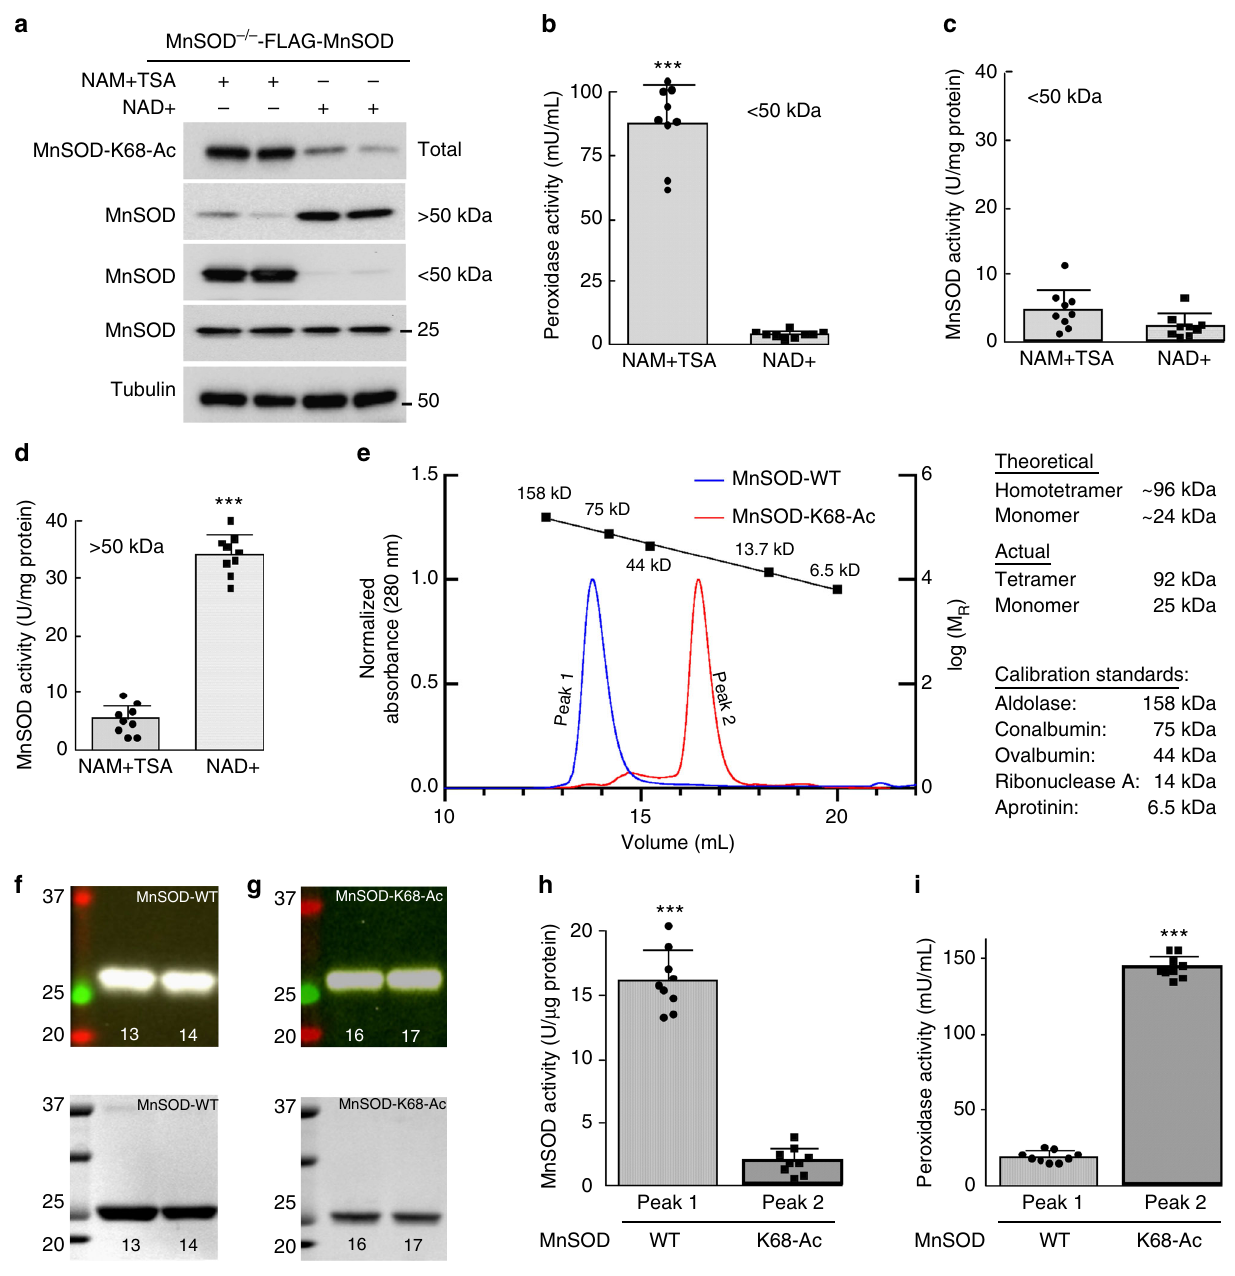
Fig. 4 The physical acetylation of MnSOD-K68 produces peroxidase activity. a – d Immortalized MnSOD − / − MEFs expressing Flag-MnSOD WT were cultured in NAM + TSA or NAD + , separated using a 50 kDa molecular cutoff membrane and a MnSOD-K68-Ac, MnSOD, and actin immunoreactive protein levels were determined. b Peroxidase activity and c MnSOD activity in < 50 kDa fractions. d The > 50 kDa fractions were analyzed for MnSOD activity. e Bacterially produced and puri fi ed recombinant MnSOD-WT and MnSOD-K68-Ac proteins were characterized by size exclusion column chromatography. Standards are shown. f , g Elution volumes 13 and 14 mL, corresponding to peak 1/blue ( f ) and elution volumes 16 and 17 mL, corresponding to peak 2/red ( g ) from Fig. 4e were analyzed for MnSOD by MnSOD-K68-Ac immunoblotting (top panels) or Coomassie Brilliant Blue staining (bottom panels). h , i Peak 1 (elution volumes 13 and 14 mL) and peak 2 (elution volumes 16 and 17 mL) were analyzed for h superoxide dismutase activity i and peroxidase activity. All experiments were done in triplicate. Errors represent ± 1 SEM. *** p < 0.01. A t -test was used to compare means of the two